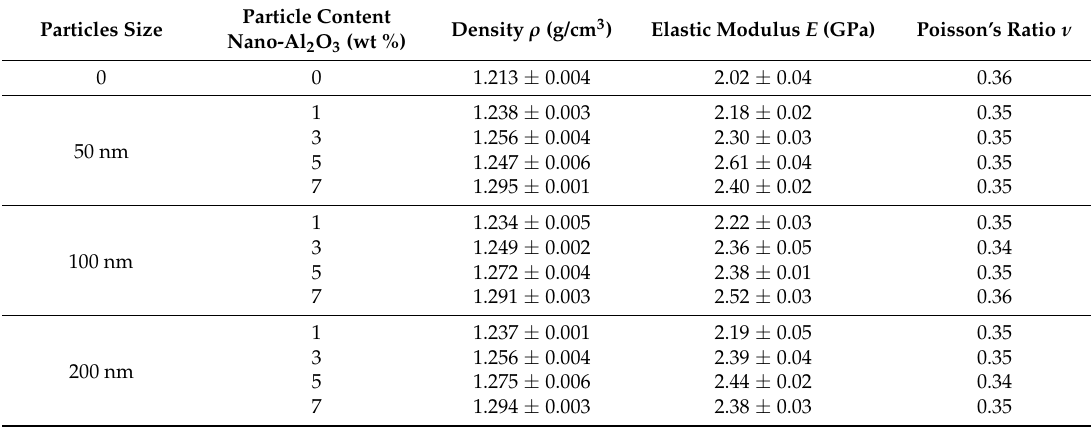
Table 1. The basic physical parameter of nano-Al 2 O 3 -filled epoxy